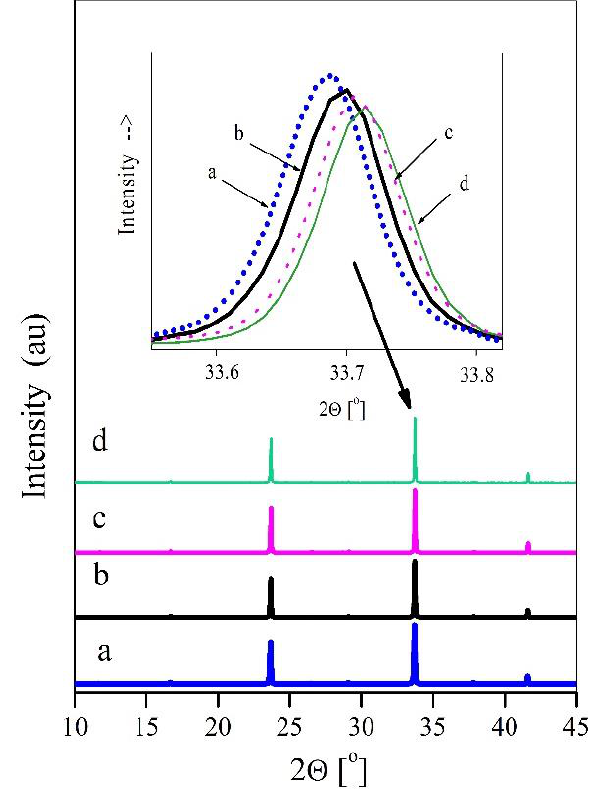
Figure 1. Fragments of X-ray diffraction patterns of: ( a ) CuTa 2 O 6 (x = 0), ( b ) CuTa 1.80 V 0.20 O 6 (x = 0.20), ( c ) CuTa 1.75 V 0.25 O 6 (x = 0.25), ( d ) CuTa 1.70 V 0.30 O 6 (x = 0.30).